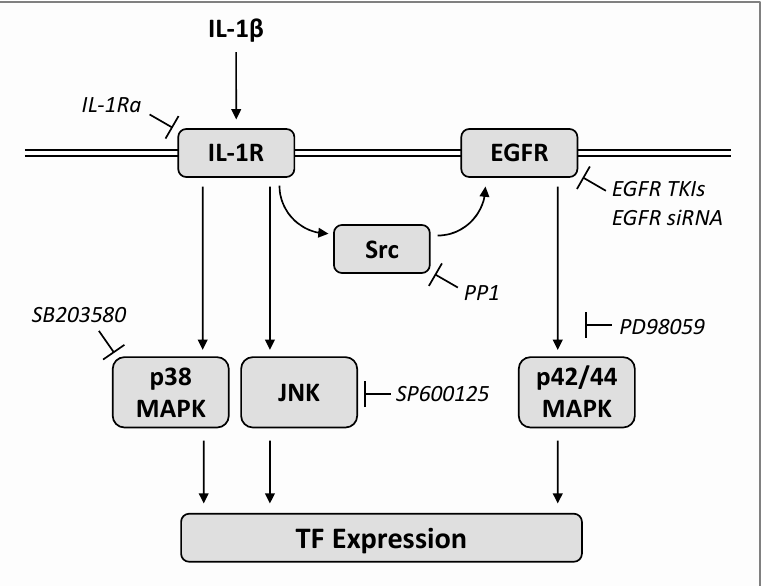
Figure 7. Proposed mechanism underlying IL-1 β -induced TF expression in A549 cells. IL-1 β induces IL-1 receptor (IL-1R)-dependent phosphorylation of p42/44 MAPK, JNK, p38 MAPK, Src and EGFR. While the activation of JNK and p38 MAPK is independent of the activation of Src and EGFR, p42/44 MAPK activation represents a Src/EGFR-dependent event. TF expression is therefore triggered by both Src/EGFR/p42/44 MAPK-dependent and Src/EGFR-independent signaling, the latter being mediated via p38 MAPK and JNK. The arrows mark the effect triggered by IL-1 β in the absence of the indicated inhibitors, which are shown in italics at the respective position of their inhibitory effect in the cascade.